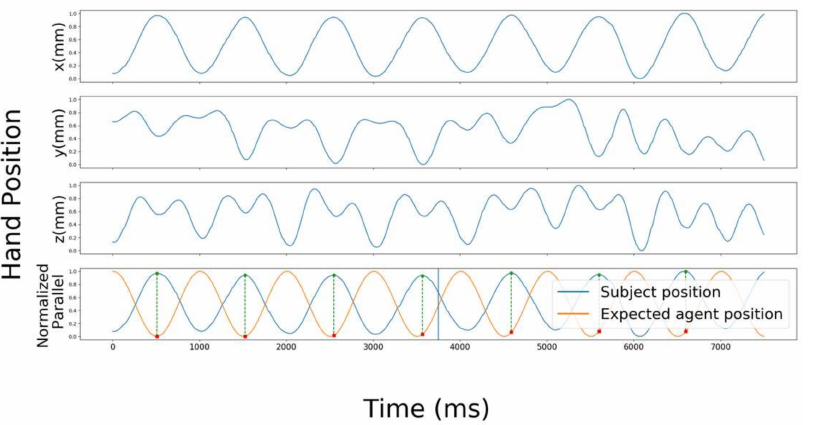
Figure 8. Recorded movement of a subject hand position and expected movement of the agent. The top three graphs show the standardized hand positions on the x, y, and z-axis, respectively. In the fourth graph, the standardized hand position on the x-axis (the same as the one in the first graph) is shown as a blue trajectory while the expected agent hand position is shown as an orange one. Circles indicate the peaks of the trajectory of the standardized hand position while the squares indicate their projected points on the trajectory of the expected agent position. The fourth graph shows the subject’s hand trajectory in which the first pick projection phase value is minus ninety degrees difference. The signals were divided into two sections by separating the phase projections of the first half time and the latter half time, as Formula (4)